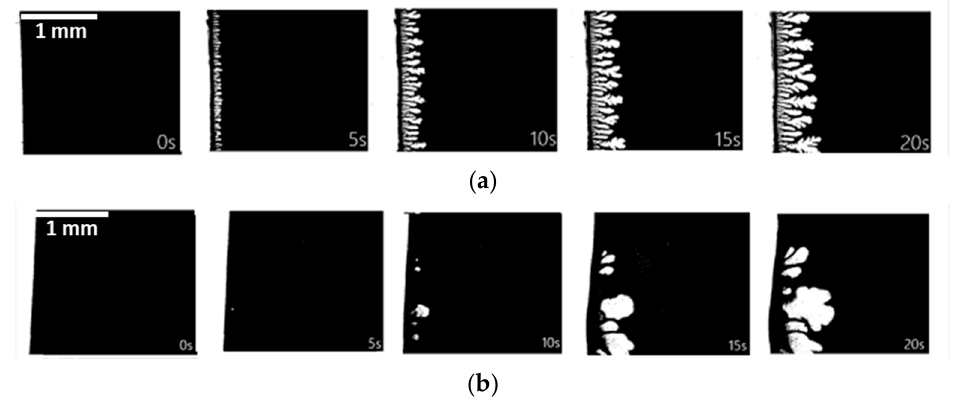
Figure 4. Binarized image series of water entrance to PVDF-TiO 2 solution at ( a ) 25 °C and ( b ) 70